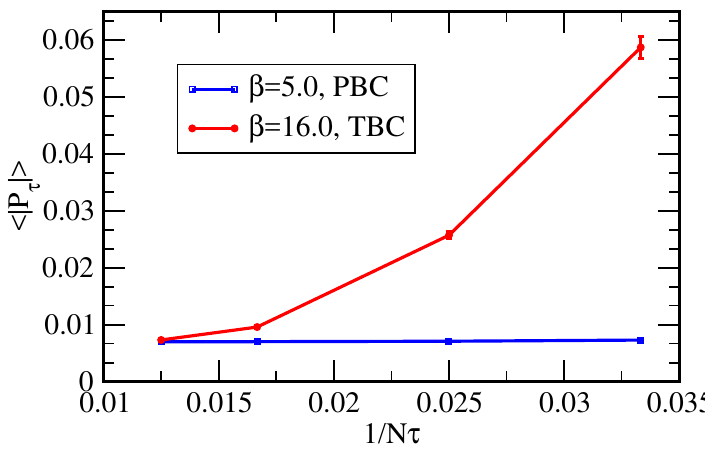
Figure 10 . Magnitude of Polyakov loop in the (cid:28) -direction as a function of N (cid:28) . We take N (cid:28) = 30 ; 40 ; 60, and 80 from right to